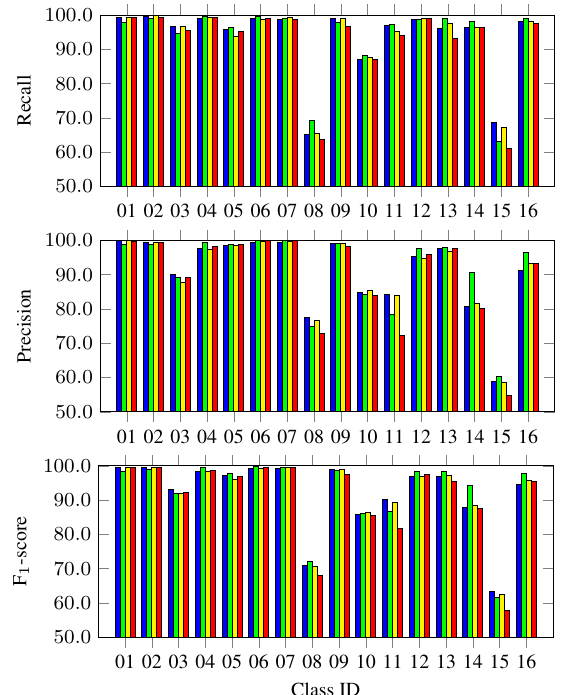
Figure 7. Recall (top), precision (center) and F 1 -score (bottom) (in %) achieved for the Salinas dataset when using different data representations as input to a Random Forest